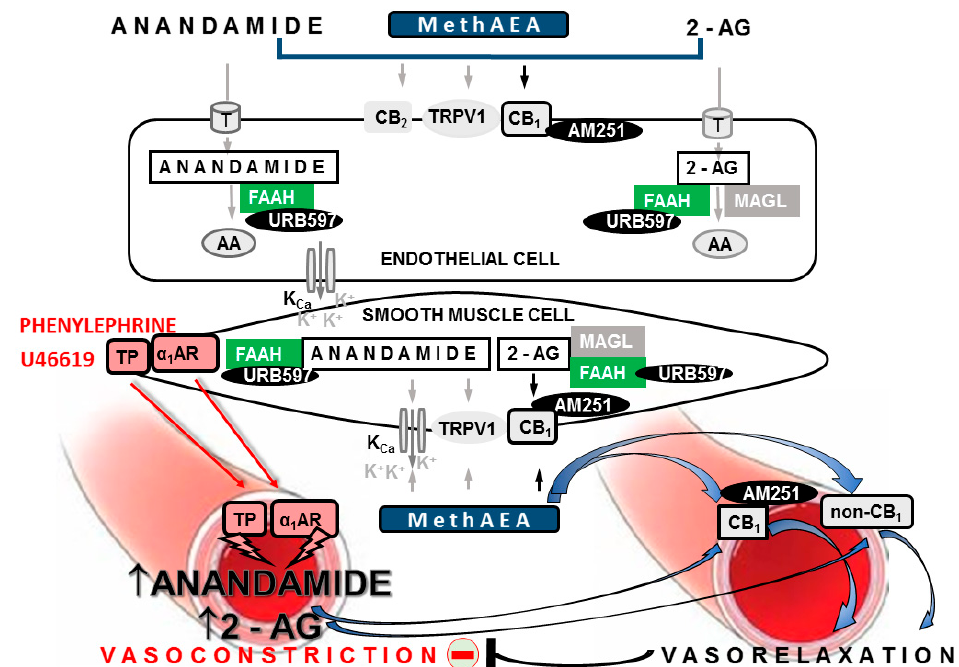
Figure 1. Summary of the mechanisms of the vasodilatory effects of endocannabinoids and their interaction with chosen vasoconstrictors in the resistance vasculature. The mesenteric arteries are used as an example. Endocannabinoids anandamide and 2-arachidonoylglycerol (2-AG), as well as methanandamide (MethAEA, synthetic stable analog of anandamide), induce relaxation of the mesenteric arteries via CB 1 -dependent and CB 1 -independent mechanisms (non-CB 1 ). CB 1 receptors are located in smooth muscle or endothelial cells. Non-CB 1 -mediated pathways include CB 2 receptors, transient receptor potential vanilloid type-1 (TRPV1) and others. Stimulation of CB 1 and non-CB 1 pathways, in turn, may result in the activation of calcium-dependent potassium channels (K Ca ) and hyperpolarization of smooth muscle cells. In addition, anandamide and 2-AG are metabolized to arachidonic acid (AA) via fatty acid amide hydrolase (FAAH) and monoacylglycerol lipase (MAGL), respectively. AA may be further converted into either vasodilator or vasoconstrictor eicosanoids (reviewed in [1,3]). Vasoconstrictors (e.g., agonists of α 1 -adrenergic receptors, phenylephrine or thromboxane TP receptors, thromboxane A 2 analog—U46619) in addition to their direct contractile effects, indirectly mediate the rapid biosynthesis of endocannabinoids. Endocannabinoids may then activate the CB 1 - and non-CB 1 -dependent vasodilatory effects. The above-mentioned endocannabinoid negative feedback leads to the reduction of the agonist-induced vasoconstriction. The components of the endocannabinoid system and drugs that were considered in this study are marked in black frames. AM251—the antagonist of CB 1 receptors; URB597—the FAAH inhibitor; T—endocannabinoid membrane transporter; black and gray arrows designate CB 1 - and non-CB 1 -mediated receptor changes, respectively; the red minus sign indicates reduction.